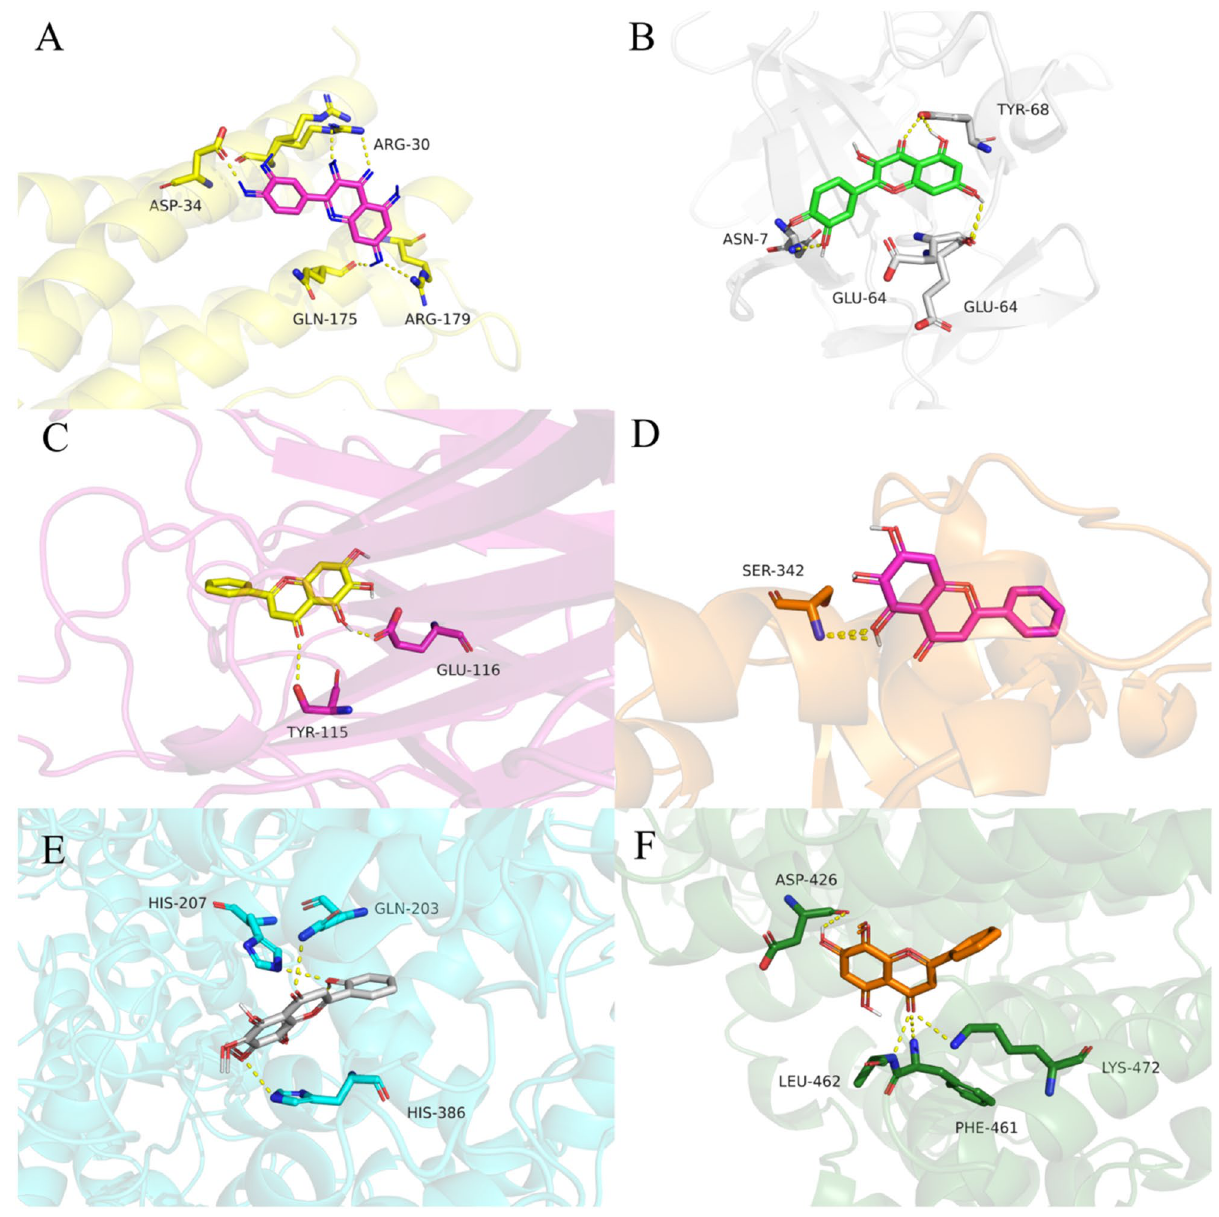
Figure 8. Molecular docking site. ( A ) IL6-quercetin. ( B ) IL1B-quercetin. ( C )TNF-baicalein. ( D )PPARG- baicalein. ( E )PTGS2-5,2 ′ -Dihydroxy-6,7,8-trimethoxyflavone. ( F )